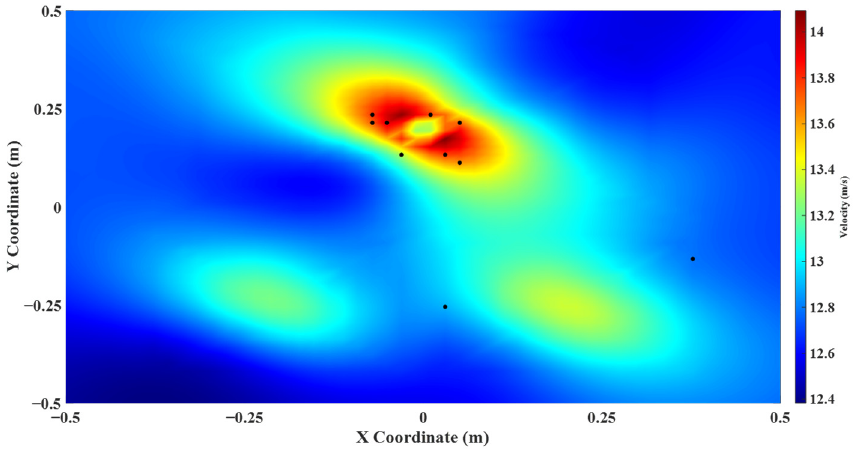
Figure 25. Reconstructed velocity nephogram (boundary condition 2) of the first plane with ten sensor positions (black points).